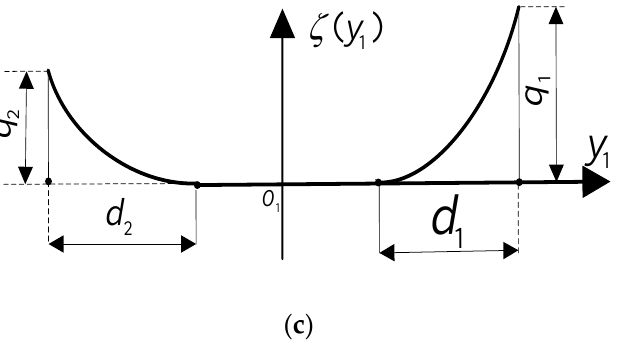
Figure 2. Ease-off design of modification surface. ( a ) The fourth-order transmission error curve. ( b ) The curved surface for the contact line modification. ( c ) The profile modification curve.